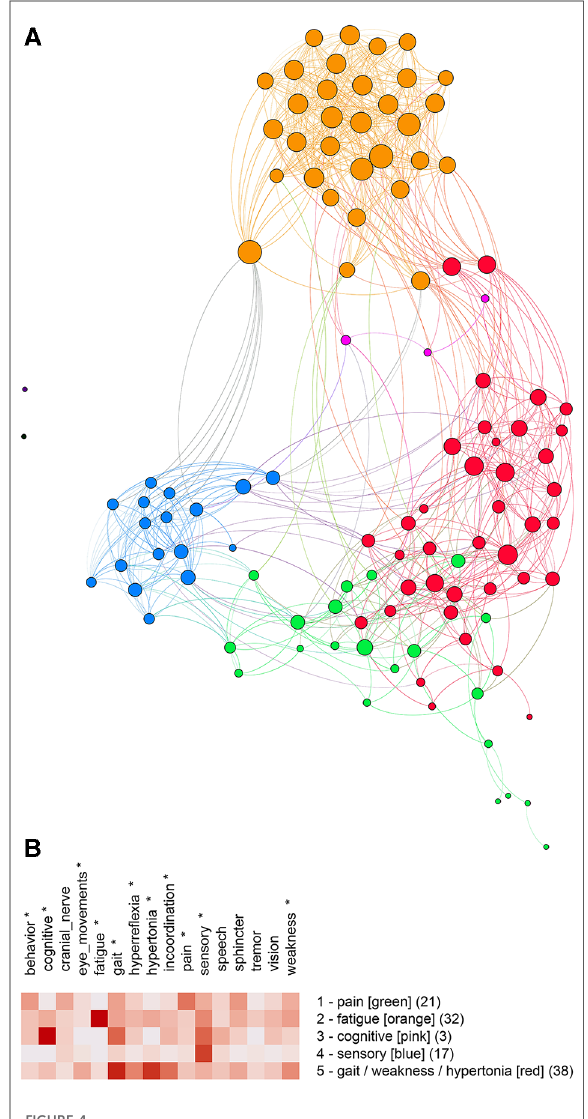
FIGURE 4 ( A ) Unipartite graph based on normalized features. Nodes are subjects, and node size is proportional to the number of edges. The largest communities are gait/weakness/hypertonia (red, n ¼ 38) and fatigue (orange, n ¼ 32). Note the small cognitive community (pink, n ¼ 3). ( B ) Feature map of the fi ve communities identi fi ed by partitioning the unipartite network graph based on normalized features. Asterisks indicate features that differed signi fi cantly by the community (One-way ANOVA, p , 0 : 05, df ¼